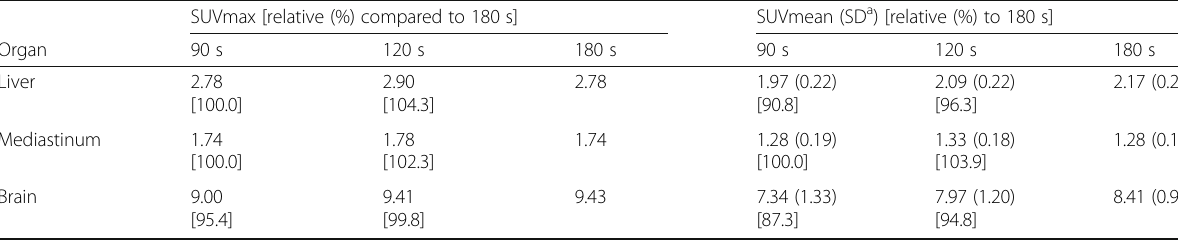
Table 6 SUVmax and SUVmean values of reference regions in the patient scans SUVmax [relative (%) compared to 180